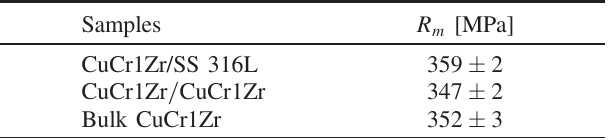
TABLE V. Tensile strengths ’ statistics, average and standard deviation “ s ” , of the specimens with the interfaces CuCr1Zr/ CuCr1Zr, CuCr1Zr/SS 316L and for specimens of CuCr1Zr without interface.